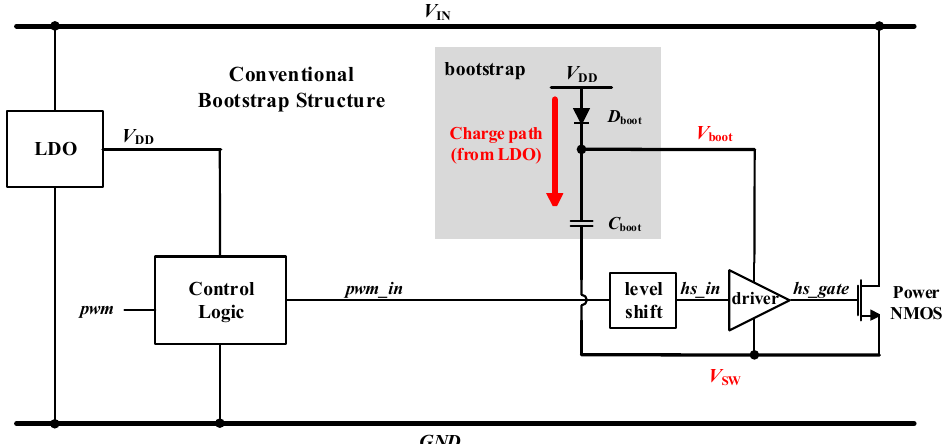
Figure 1. Traditional bootstrap structure charging from an LDO, which brings bandwidth and stability pressure to LDO.